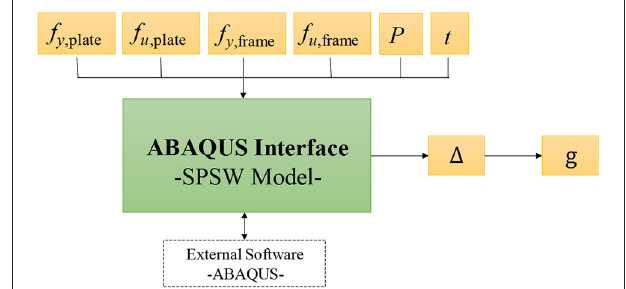
FIGURE 6 | Flow of information between Rt and ABAQUS.